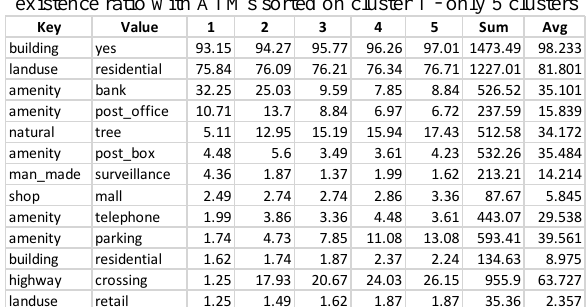
Table 8 Partial result for analysis of RP objects with high co- existence ratio with ATMs sorted on cluster 1 - only 5